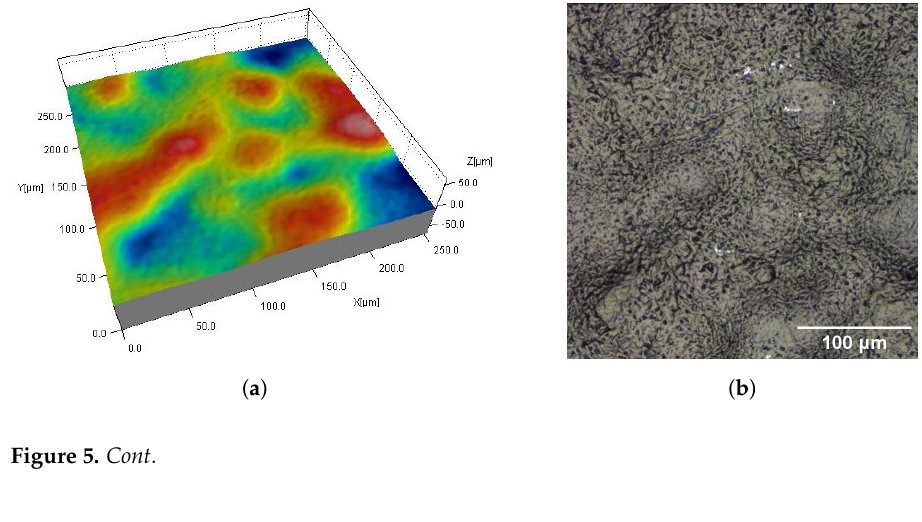
Figure 4. Surfaces of SLS samples after mechanical smoothing DM_PSC ( a , b ) and DM_PSC_Col ( c , d ): fragments 0.5 mm × 0.5 mm of 3D maps ( a , c ) and corresponding 2D views ( b , d ).